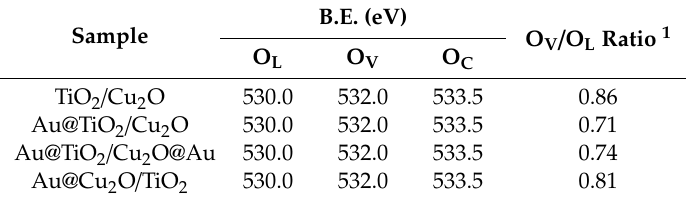
Table 2. O 1s XPS analyses of the samples.